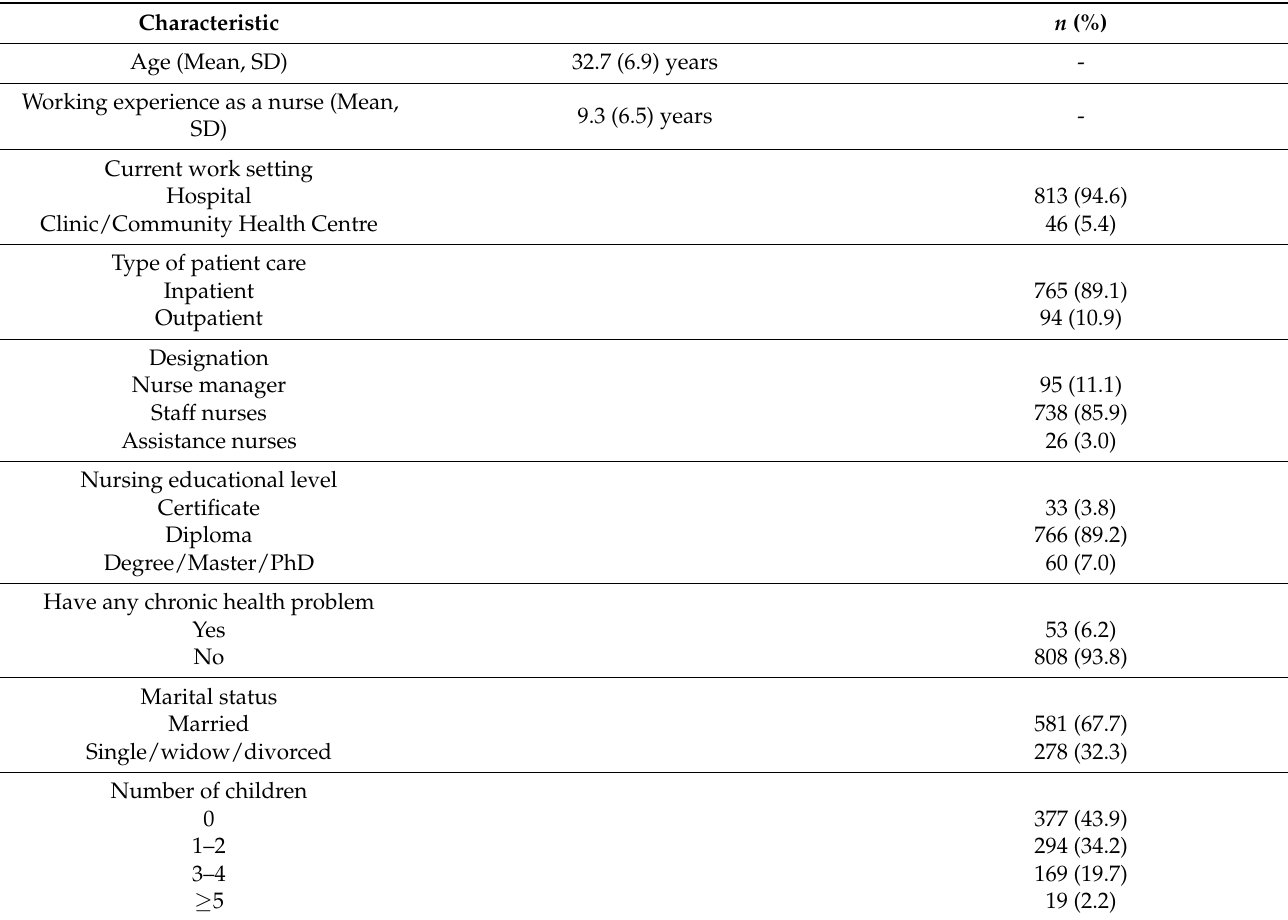
Table 1. Characteristics of nurses (N =